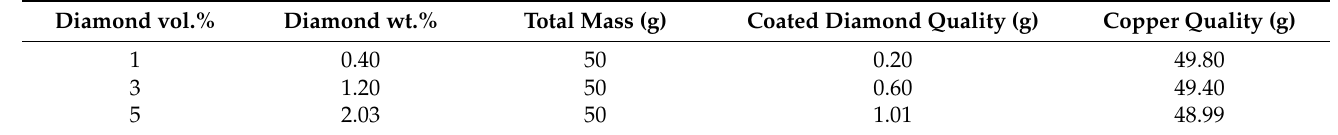
Table 1. The coated diamond/copper composite compositions. Diamond